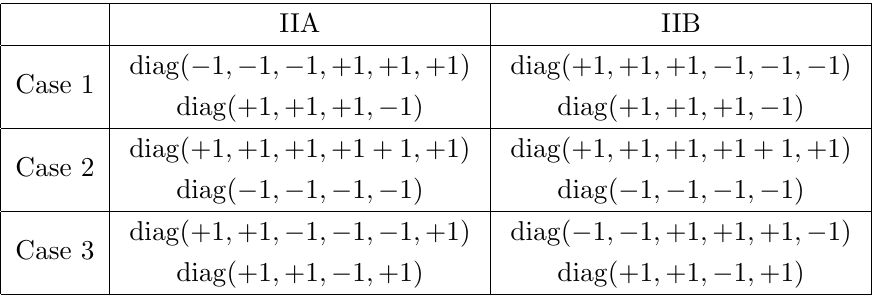
Table 11 . Reduction of the ExFT Z 2 producing DFT actions Z MN and Z AB